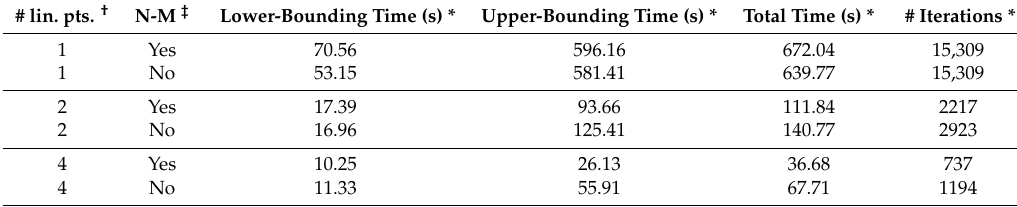
Table 3. The solution statistics for our implementation when applied to (9).